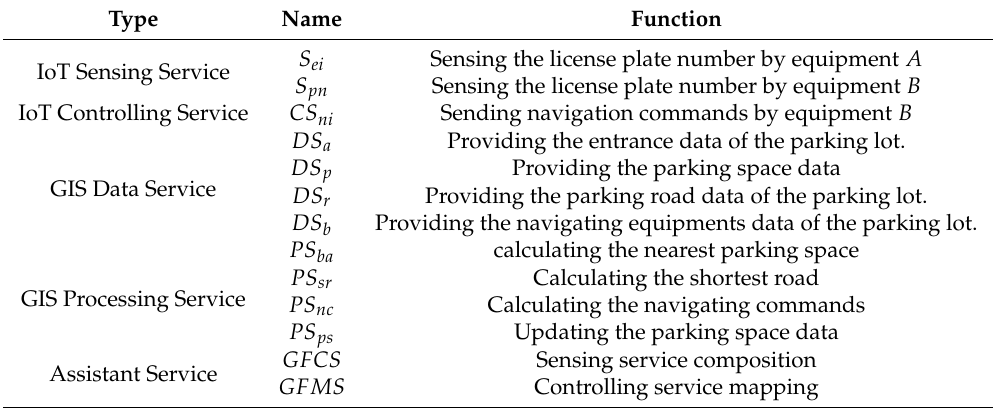
Table 3. The services in the parking lot.